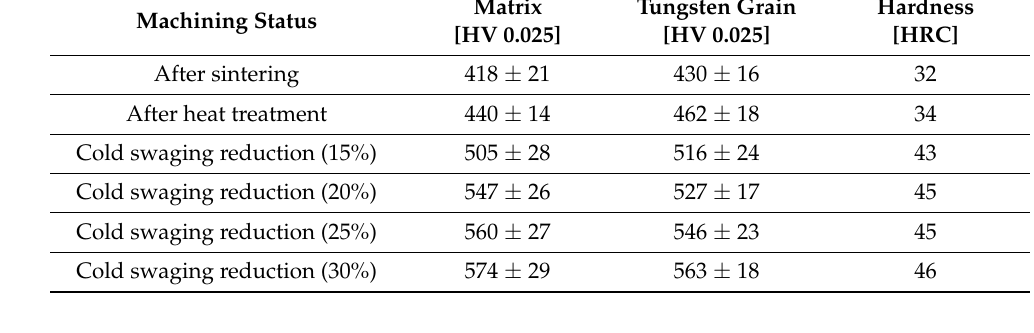
Table 3. Results of measurements of microhardness HV 0.025 and hardness HRC.